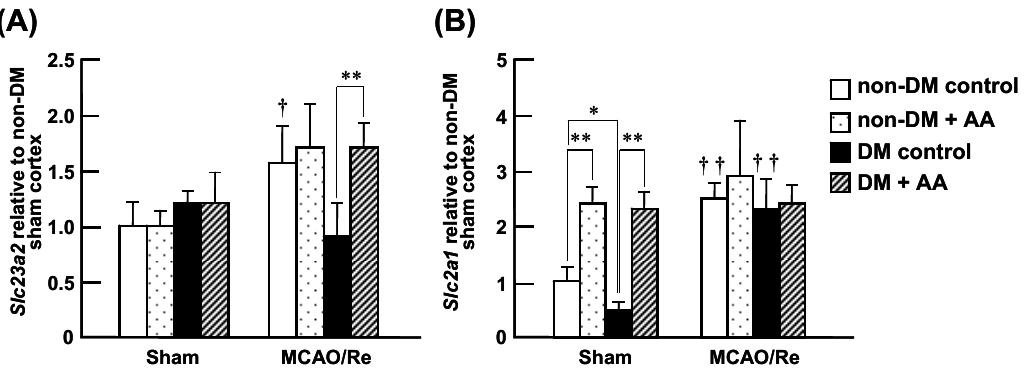
Figure 8. Effects of AA supplementation on SVCT2 and GLUT1 mRNA expression in the ischemic penumbral cortex of nondiabetic and diabetic rats. Expression levels of SVCT2 mRNA ( Slc23a2 ) ( A ) and GLUT1 mRNA ( Slc2a1 ) ( B ) were assessed using real-time PCR analysis of the penumbral cortex of nondiabetic and diabetic rats after MCAO/Re. The data are presented as mean ± SD ( n = 3–6). † p < 0.05, †† p < 0.01 compared with the respective sham-operated controls. * p < 0.05, ** p <